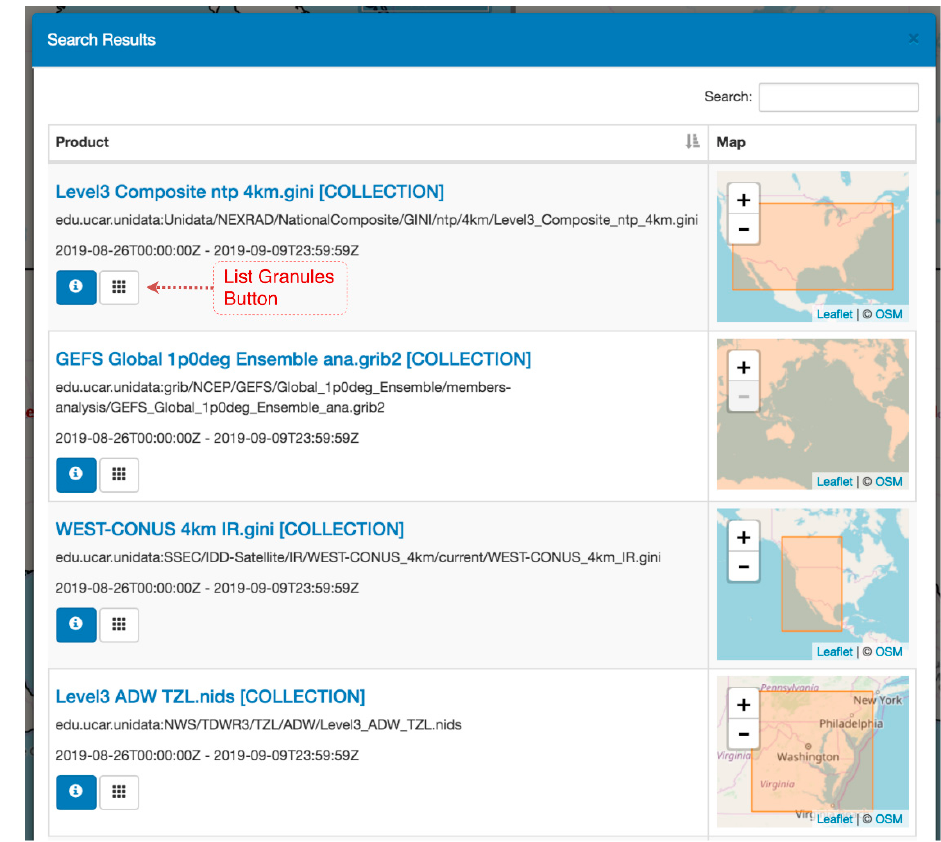
Figure 11. Search client web interface.